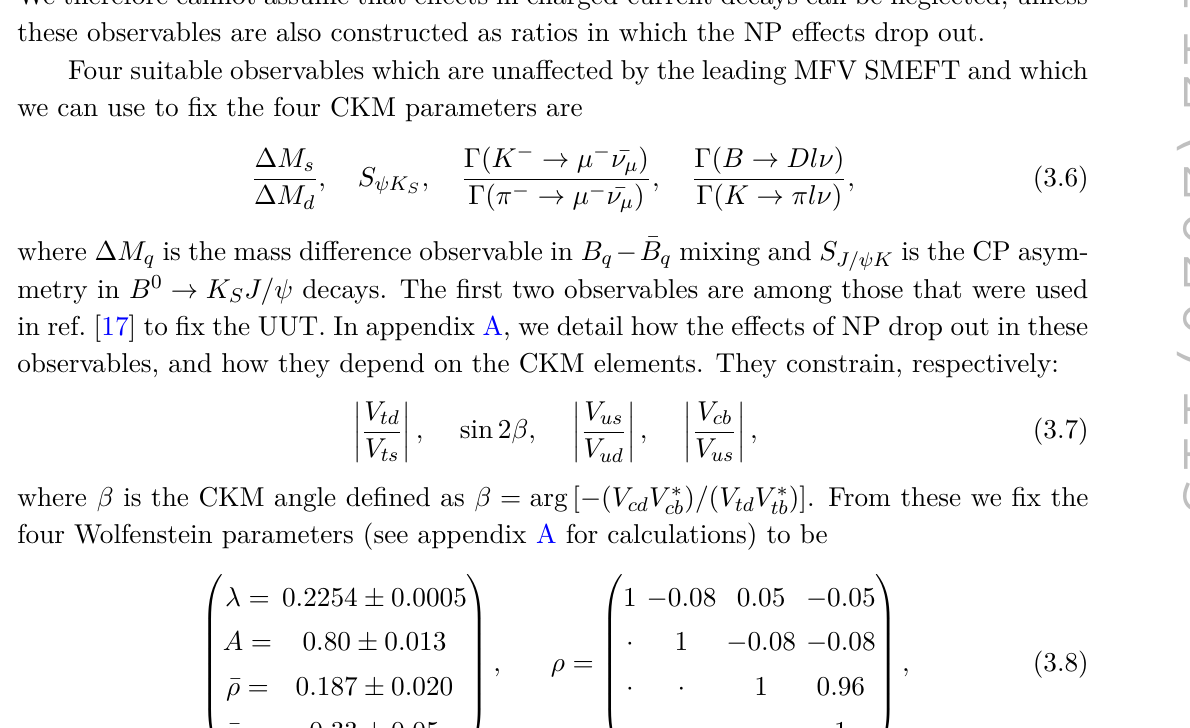
, Q (3) , and Q (3) Hq lq Hl